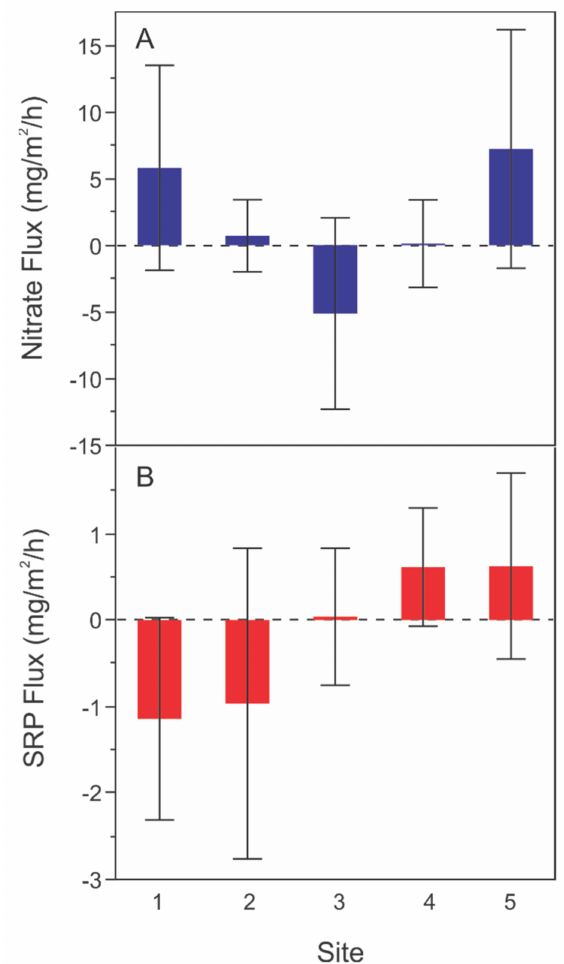
Figure 3. Sediment core ( A ) nitrate and ( B ) soluble reactive phosphate (SRP) flux rates by site for all months and depth habitats combined at each site. Negative values indicate a movement of nitrate or SRP from the water to the sediments and positive values indicate nitrate or SRP release from the sediments into the water. Bars are the means across depths and months, and error bars are 95% confidence